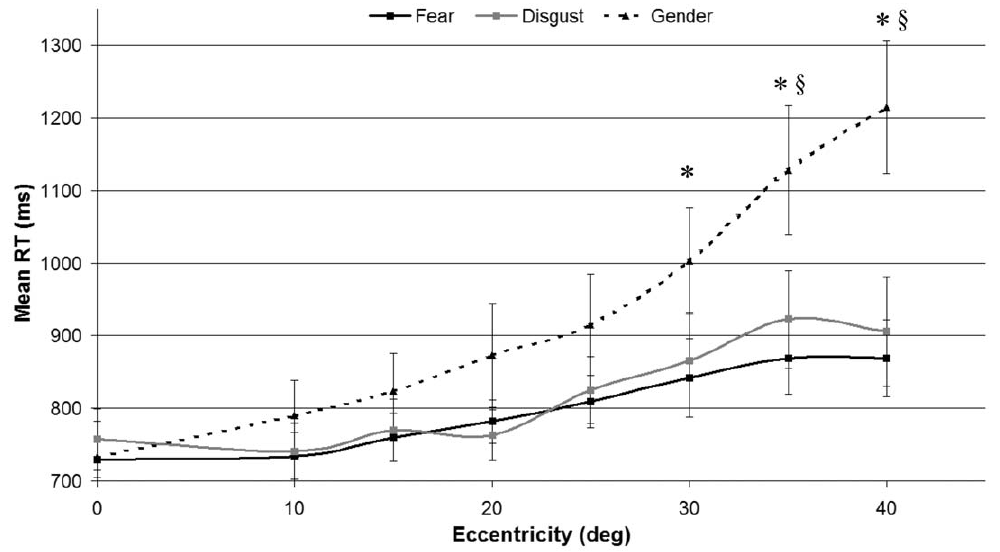
Figure 1. Reaction times as a function of eccentricity in the three discrimination tasks: * marks a significant difference between gender and fear discrimination reaction times, 1 a significant difference between gender and disgust discrimination reaction times. Vertical bars represent standard errors of the mean values.